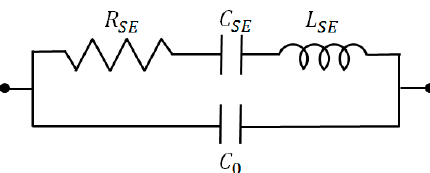
Figure 3. Electric Butterworth-Van-Dyke (BVD) model to represent an equivalent circuit of a single resonant frequency transducer [28,48].